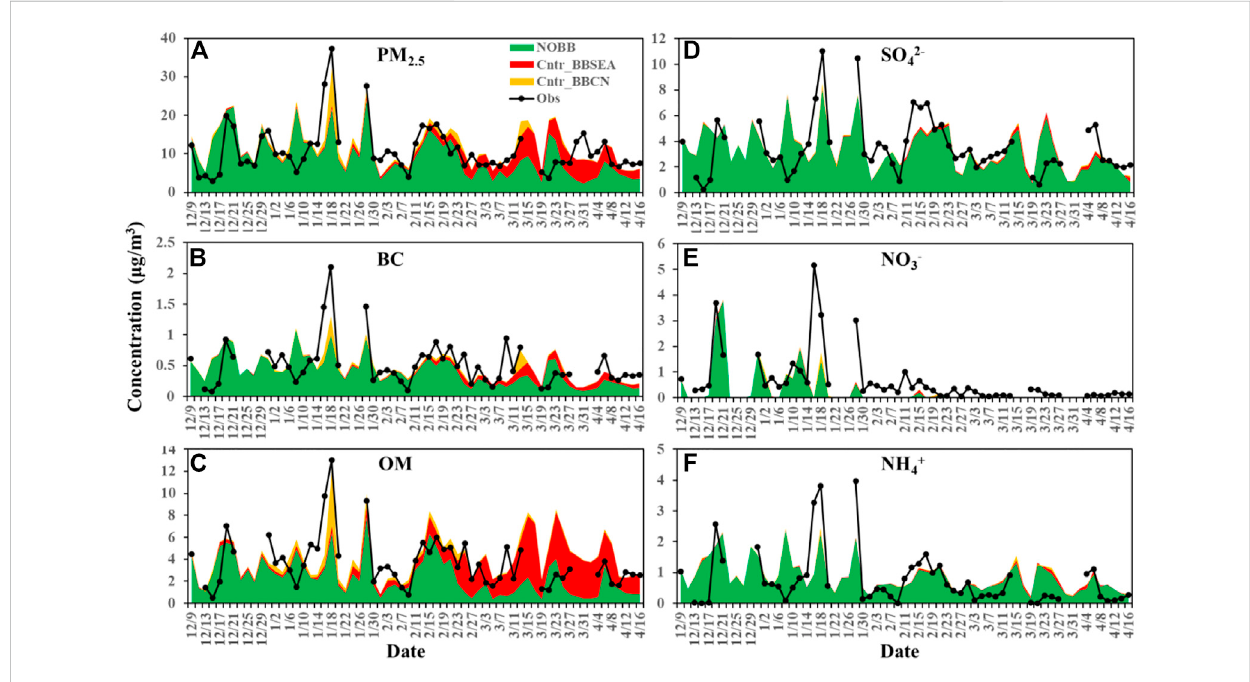
FIGURE 2 Modelcomparisons withmeasurementsofdailyconcentrationsof (A) PM 2.5 , (B) BC, (C) OM, (D) sulfate(SO 4 2- ), (E) nitrate(NO 3 − ),and (F) ammonium (NH 4 + ) at the Wuzhi Mountain site. Black dotted lines are observations, colored shadings are corresponding simulations attributed to anthropogenic sources (NOBB, green), biomass burning emissions from mainland Southeast Asia (Cntr_BB SEA , red), and biomass burning emissions from China (Cntr_ BB CN , orange). Blanks are missing